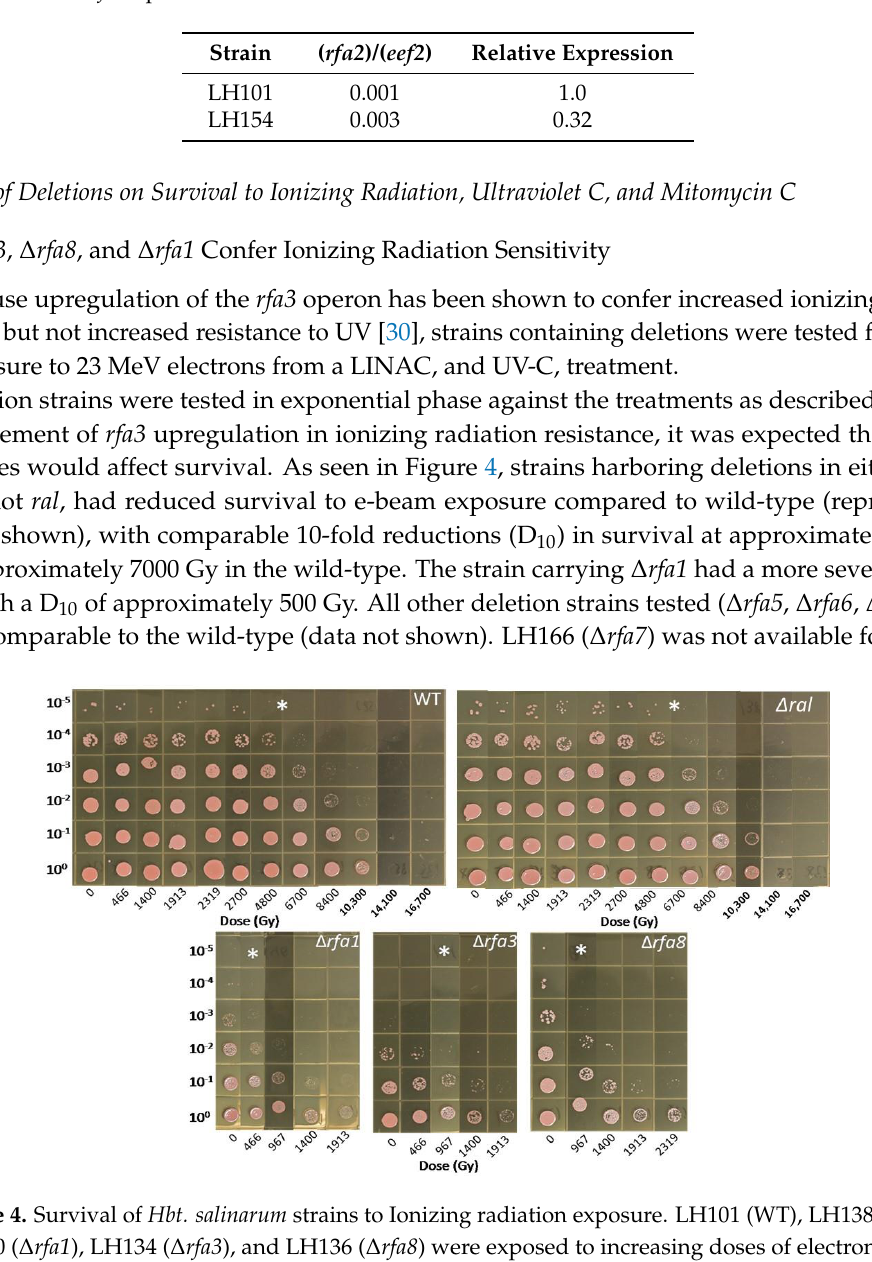
Table 3. Expression of rfa2 in suspected rfa2 deletion strain relative to the wild-type. Expression was normalized to eef2 expression.